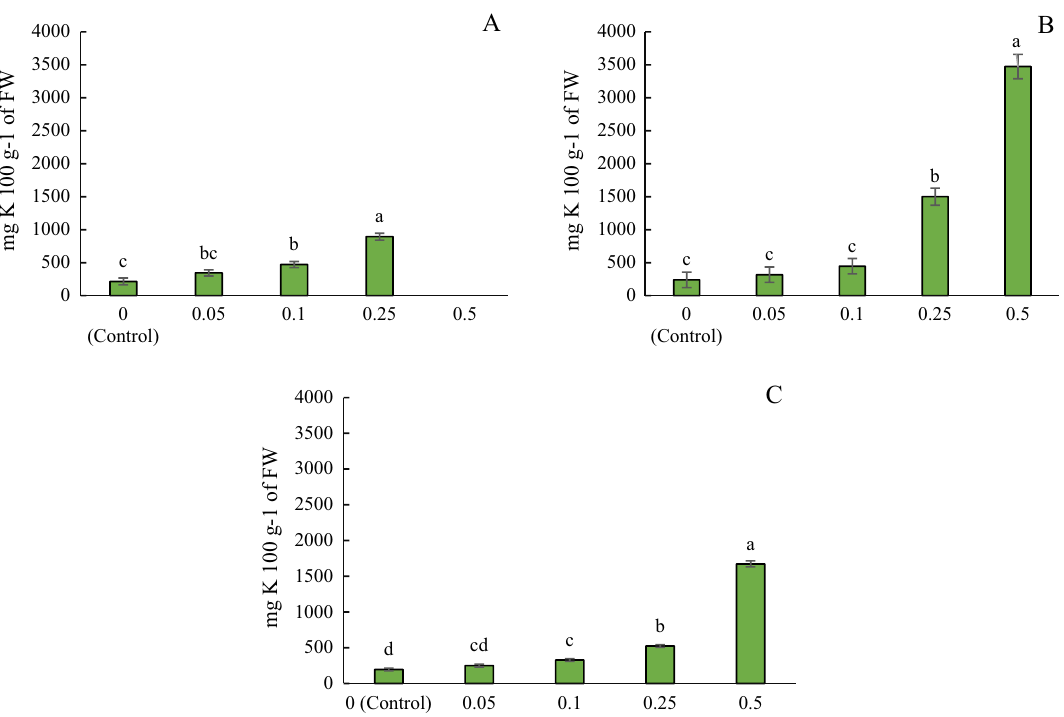
Figure 2. Potassium concentrations in microgreens treated with ascorbic acid and KOH buffer in ( A ) Experiment 1—greenhouse conditions, ( B ) Experiment 2—greenhouse conditions, and ( C ) Experiment 3— laboratory conditions. Significant differences ( p ≤ 0.05) among treatments are indicated by different lowercase letters within the experiment. (n = 5). Bars represent ± 1 standard error of the mean. FW fresh